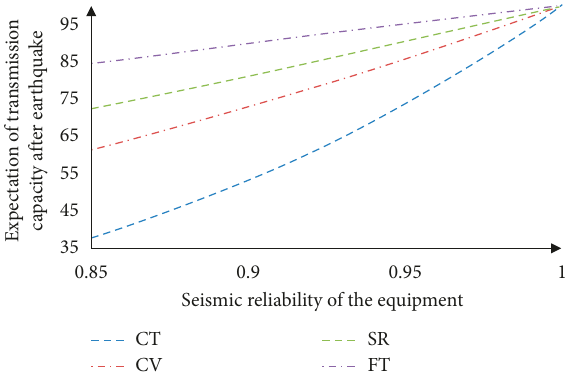
Figure 9: Impact of equipment reliability on overall system